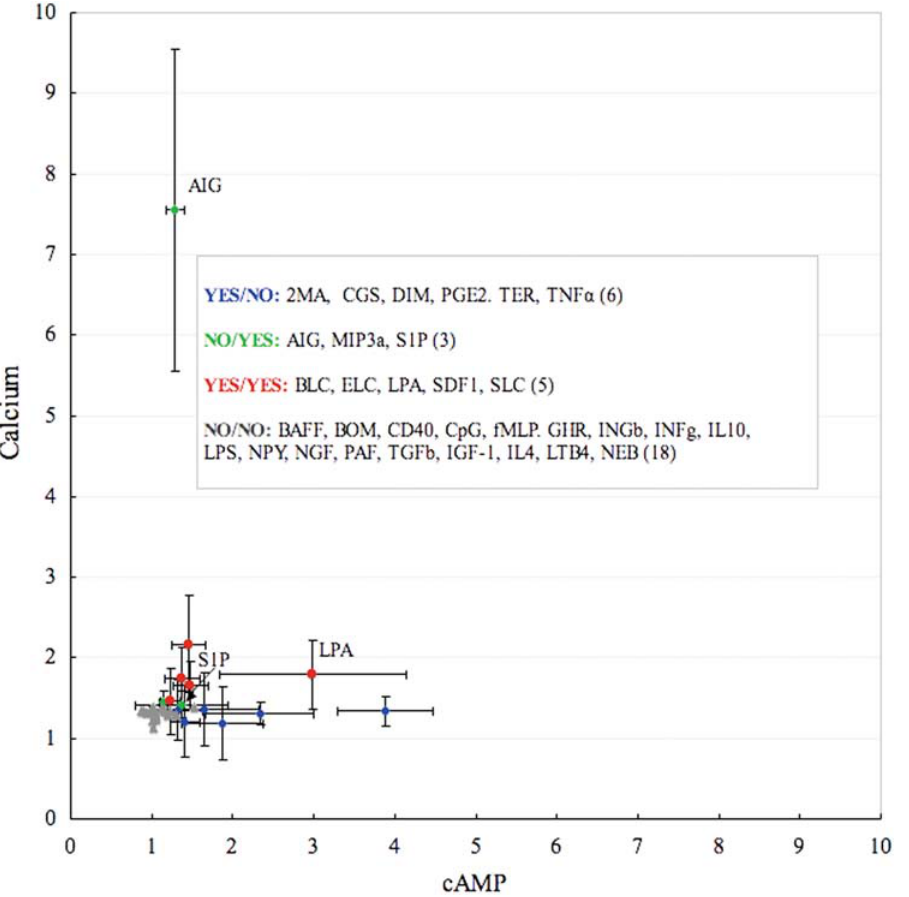
Figure 2. Peaks of fold changes for 32 B-Cell ligands classified into four groups with observed ‘YES’ and non-observed ‘NO’ elevation of cAMP and Ca 2 + . Standard deviations (SD) are shown by the vertical bars. Full names for the ligands are listed in Table S1. S1P and LPA ligands are marked to be visible as they are given more detailed discussion in the manuscript.